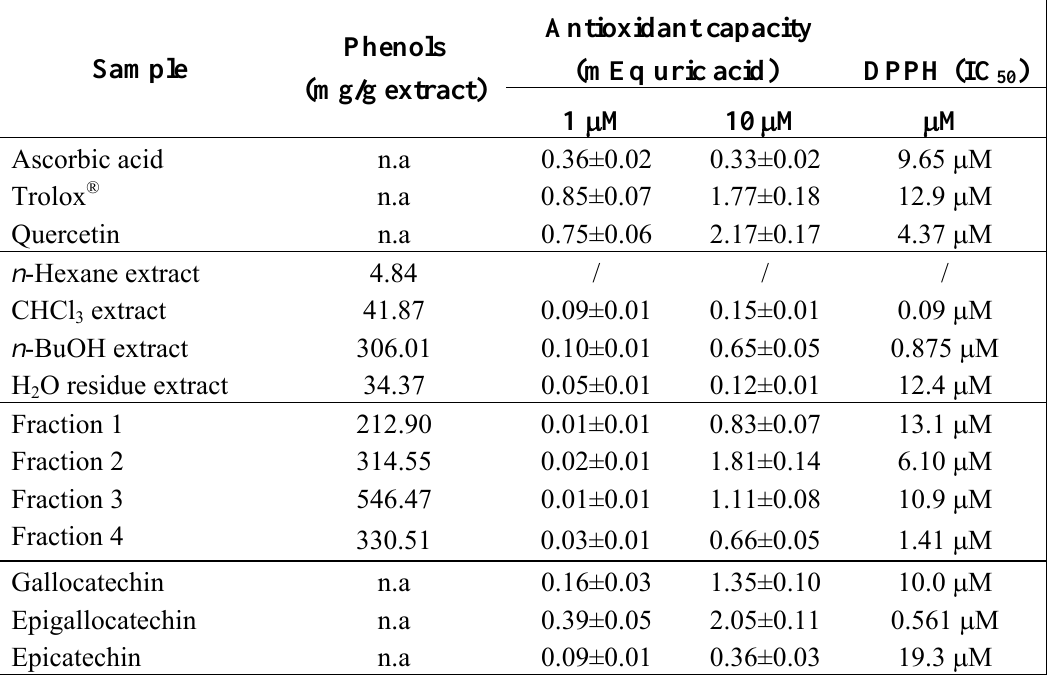
Table 2. Phenolic content and antioxidant activity of extracts, fractions, and pure compounds isolated from C. lechleri